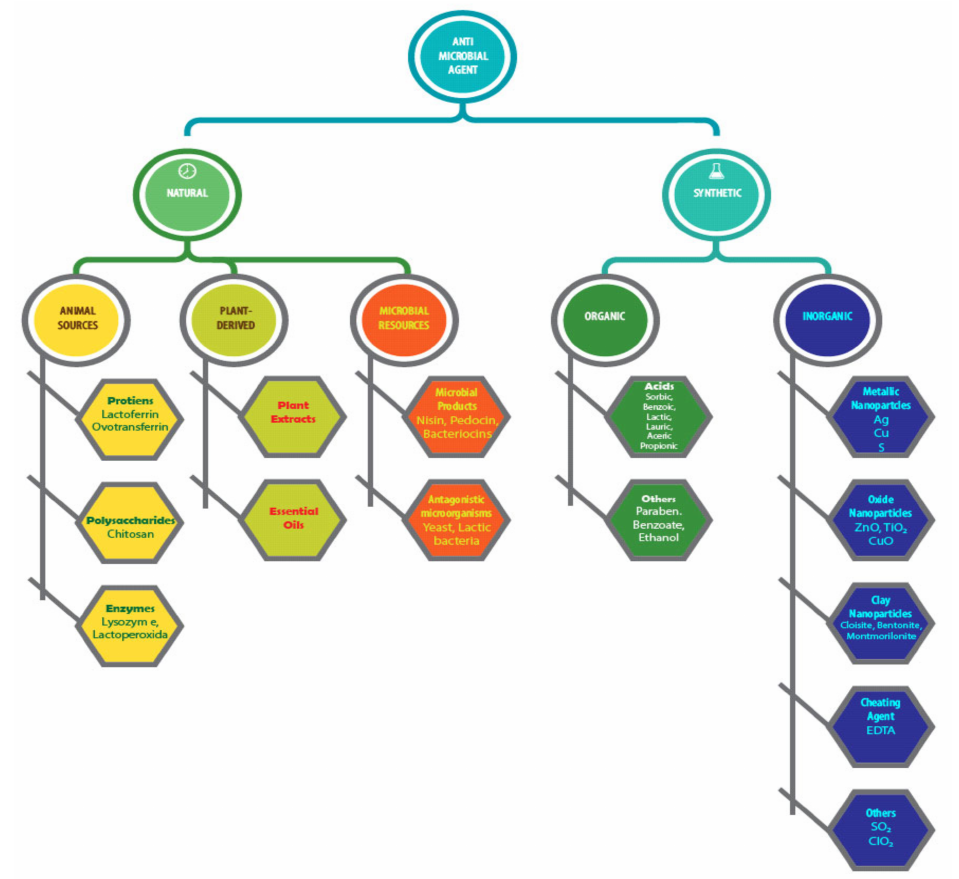
Figure 3. Classification of antimicrobial agents. Modified from